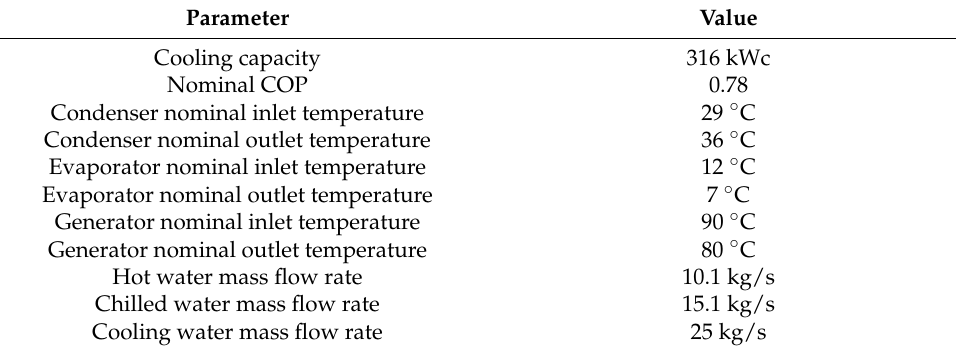
Table 6. Absorption chiller technical